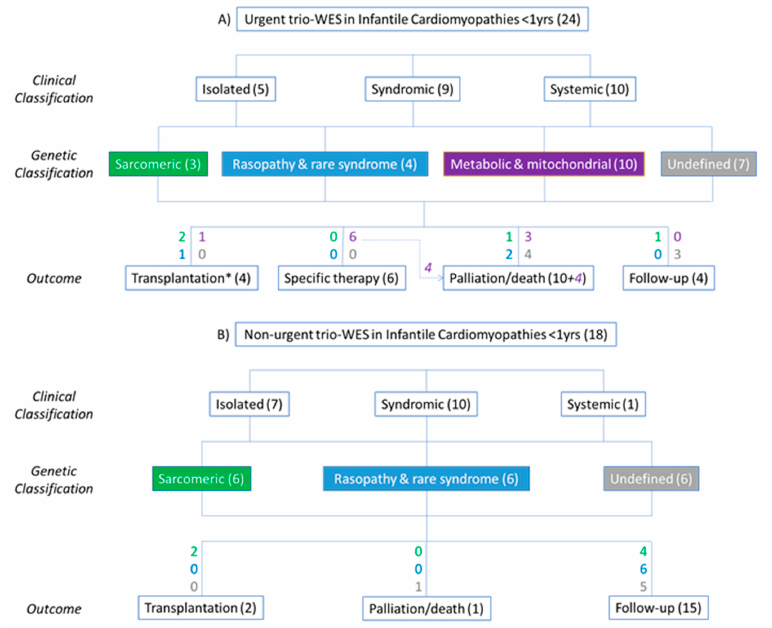
Figure 5. Flowchart describing the main results of trio-WES analysis in infantile cardiomyopathies, performed in urgent ( A ) and non-urgent ( B ) settings; * 1 patient underwent liver transplantation (tyrosinemia).